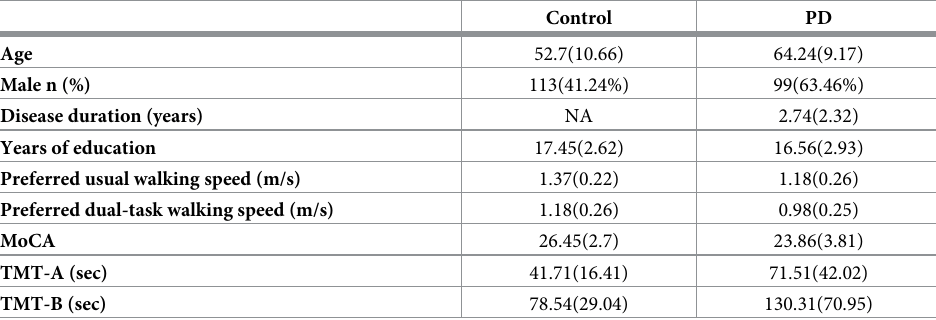
Table 1. Patients